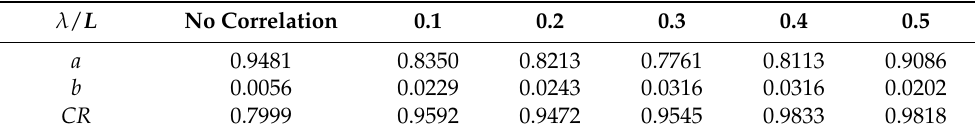
Table 2. Values of parameters a and b of Equation (10) determined based on λ / L